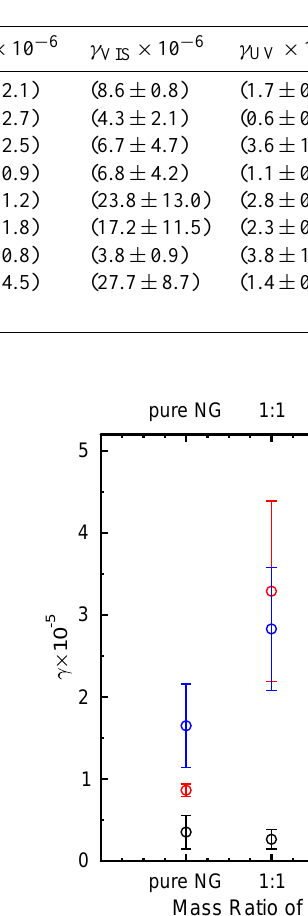
Table 2. Steady-state reactive uptake coefficients, γ , of organic substrates representative of BBA compounds with O 3 under dry conditions and with atmospherically relevant O 2 levels. γ was determined in the dark and under VIS and UV irradiation. O 3 concentrations ranged between 3 . 5 × 10 11 and 6 . 0 × 10 11 moleculecm − 3 , and substrate temperatures ranged between 20 and 23 ◦ C. Uncertainty is ± 1 σ .